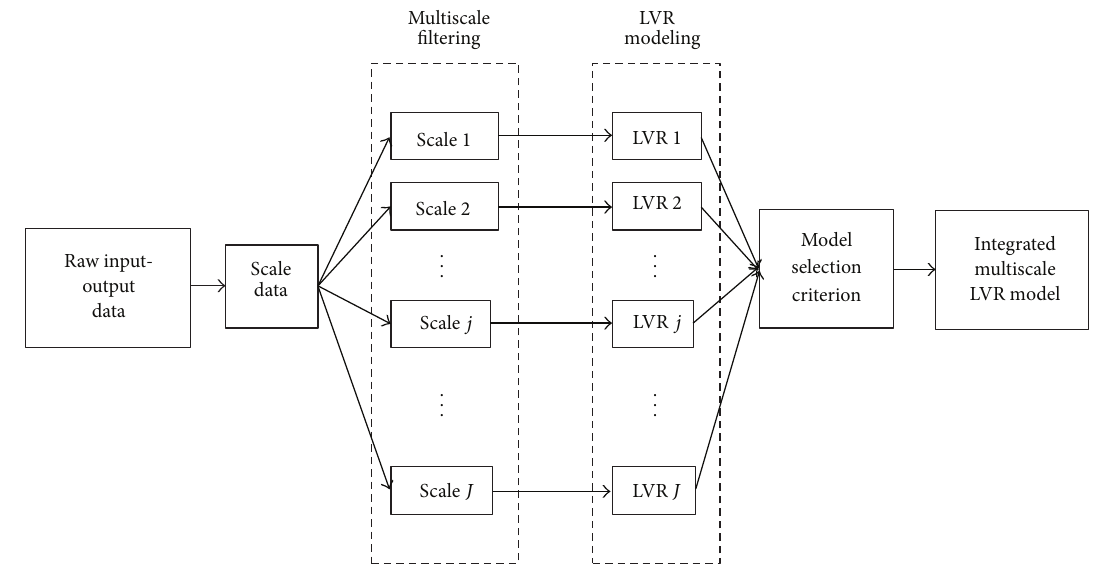
Figure 2: A schematic diagram of the integrated multiscale LVR (IMSLVR) modeling